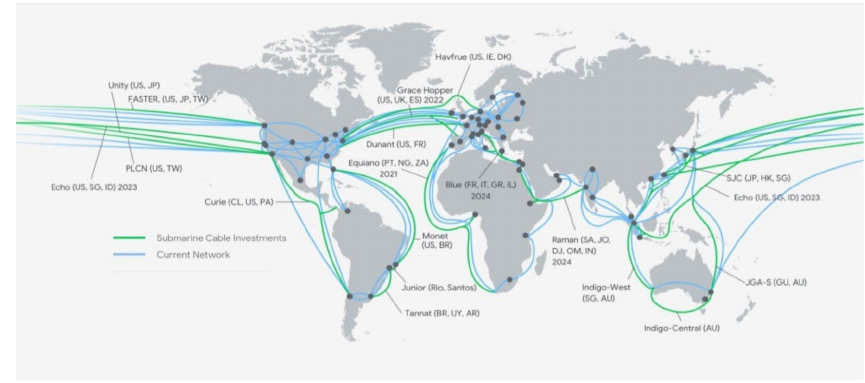
Figure 4. Google cloud platform submarine network [3].